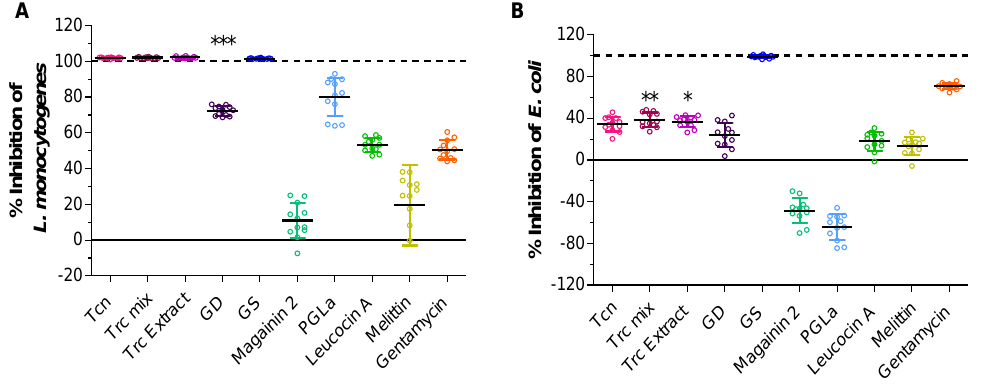
Figure 6. Antimicrobial activity (expressed as % Inhibition) of peptide-treated cellulose against ( A ) L. monocytogenes and ( B ) E. coli . % Inhibition is calculated/normalised by the natural activity of the base material cellulose. Gentamycin was used as antibiotic control. Each data set represents three biological and four technical repeats. Statistical analysis was performed with One-way ANOVA (Boferroni’s multiple comparison test) against GD versus Tcn, Trc mix, Trc extract , and for ( A ) *** p < 0.0001 and ( B ) ** p < 0.01 and * p < 0.05. Full statistical analysis can be found in the Supplementary Materials -Tables S4 and S5.